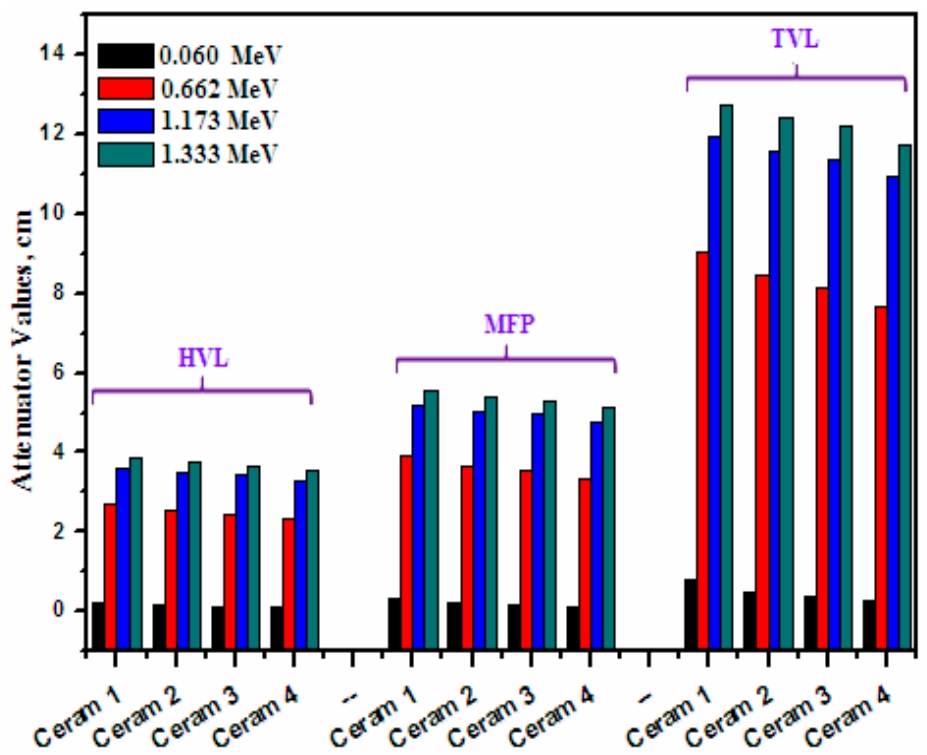
Figure 7. The HVL, MFP, and TVL for the prepared ceramics. Figure 10 graphs the LAC of the four ceramic samples, as well as four other radia- tion shielding materials, at two chosen energies, 0.060 MeV and 0.662 MeV. The other four materials added for comparison are granite and marble [38], two other common materials, and Kaolin + 30% micro Bi 2 O 3 and Kaolin + 30% nano Bi 2 O 3 [39], which have been previously tested and proposed as shielding materials. At both energies, granite and marble have the lowest LAC values, while Ceram 2–4 have the greatest LAC values, with ceramic 4 having the greatest LAC value out of all the samples. More specifically, ceramic 4 has an LAC value of 7.823 cm − 1 at 0.060 MeV and an LAC value of 0.300 cm − 1 at 0.662 MeV. At 0.060 MeV, both the Kaolin-based shields have a higher LAC than Ceram figure reinforces the conclusion that the investigated ceramics are adequate materials to be used for radiation shielding purposes.